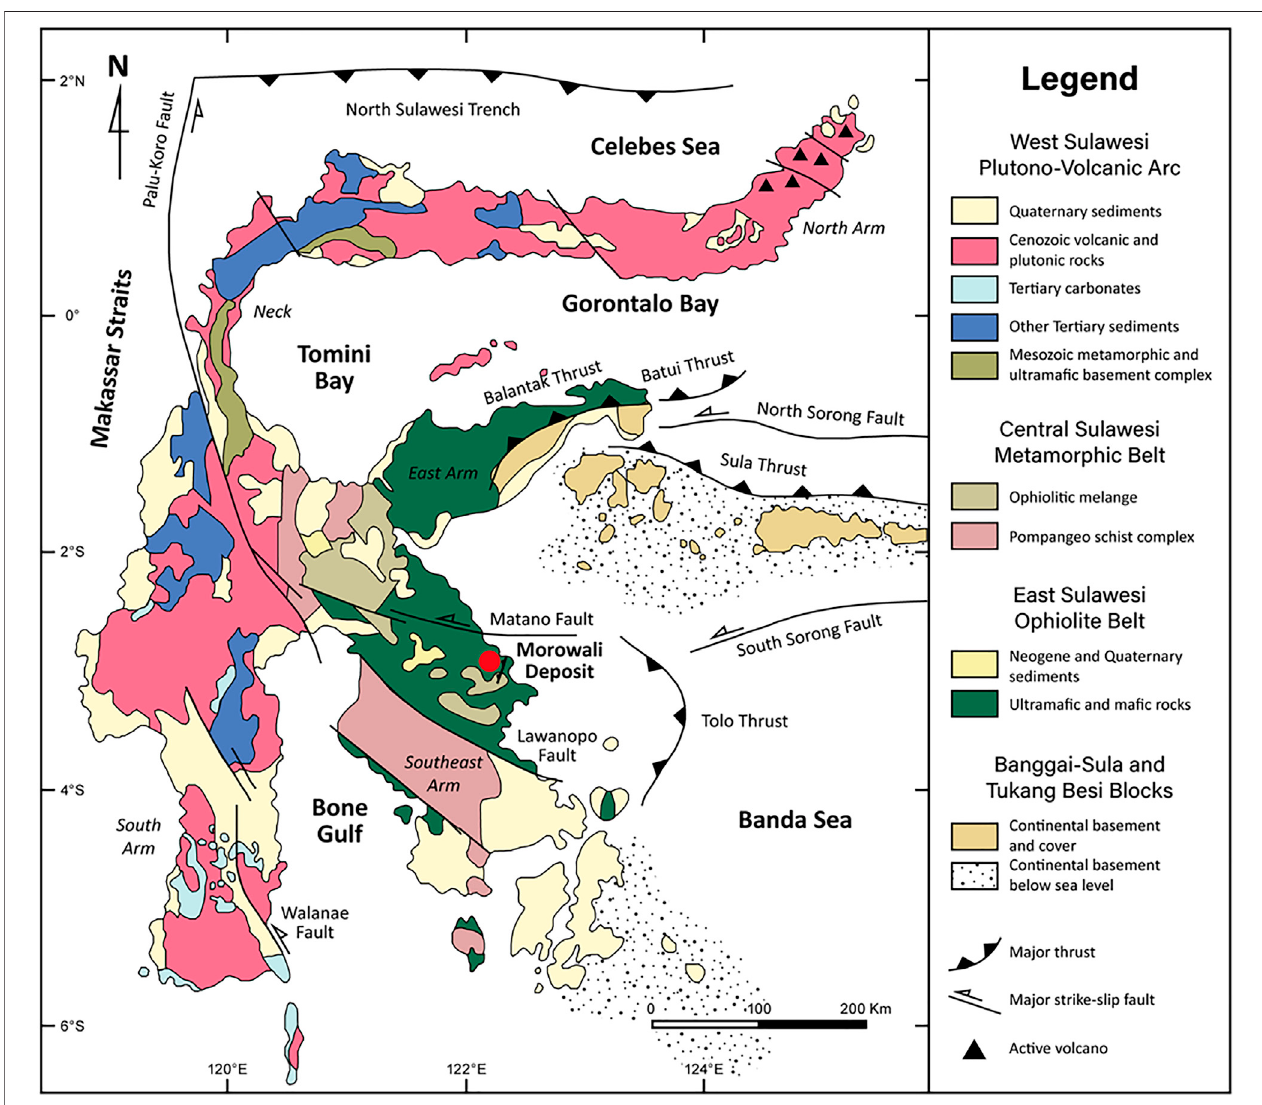
FIGURE 1 | Geological map of Sulawesi island, Indonesia and location of Morowali deposit (modi fi ed after Hall and Wilson (2000)). The location of the Morowali deposit is shown in the red circle.